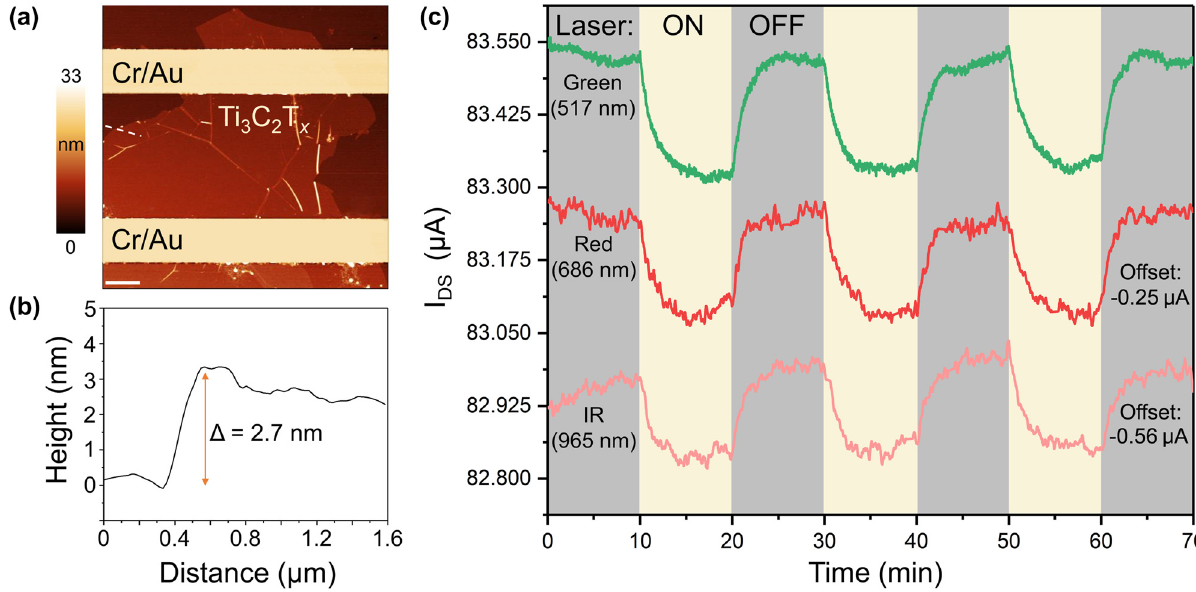
C T flakes to lasers with different wavelengths. (a) False-color AFM image of a Figure 3: Negative photoresponse of monolayer Ti 3 2 x C T MXene flake. Scale bar: 1 μ m. The Cr/Au electrodes are colored in yellow for clarity. (b) two-terminal device based on a monolayer Ti 3 2 x AFM height profile measured along the white dashed line in panel (a). (c) The modulation of photocurrent in Ti different lasers, IR (965 nm), red (686 nm), and green (517 nm). All lasers were set to the same power of 3.5 mW. The measurements were = 0.1 V and V = 0. The I axis corresponds to the electrical measurement involving the green light; the other two performed at V DS G DS dependences are vertically offset for clarity by − 0.25 𝜇 A (red laser) and − 0.56 𝜇 A (IR laser),